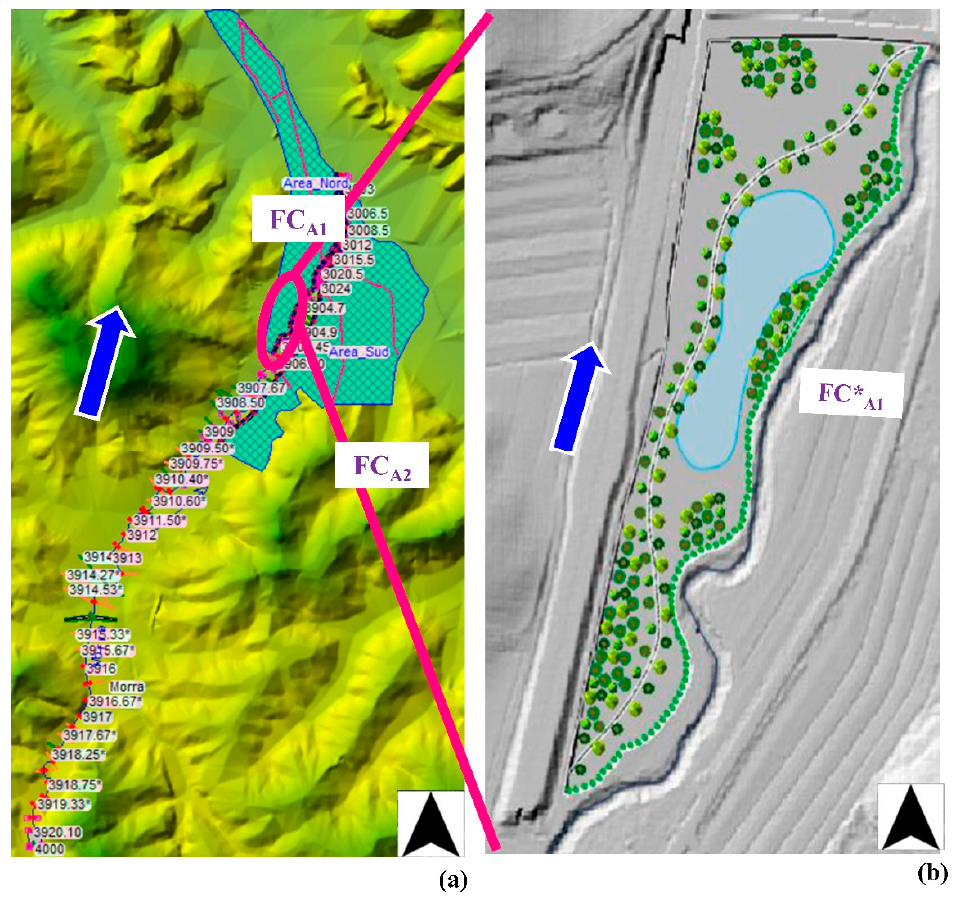
Figure 7. ( a ) HEC-RAS v5.0 geometry models associated with Morra Creek and the two vegetated flood control areas indicated as FC A1 and FC A2 adopted in green–blue scenario II. The * in the figure is just due to the software output visualization. ( b ) View of the single flood control area FC* A1 , representing an alternative solution to FC A1 and FC A2 areas. The blue arrow indicates the flow direction.